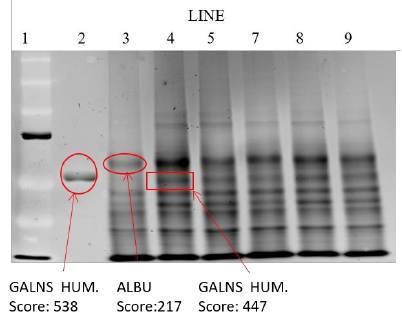
Figure 9. Electrophoretic mobility shift assay of the extracts of cells after co-incubation with elosulfase alfa-NLC. Line 1—molecular weight standards; line 2—elosulfase alfa; Line 3—untreated chondrocytes; Line 4—chondrocytes with elosulfase alfa-NLC.